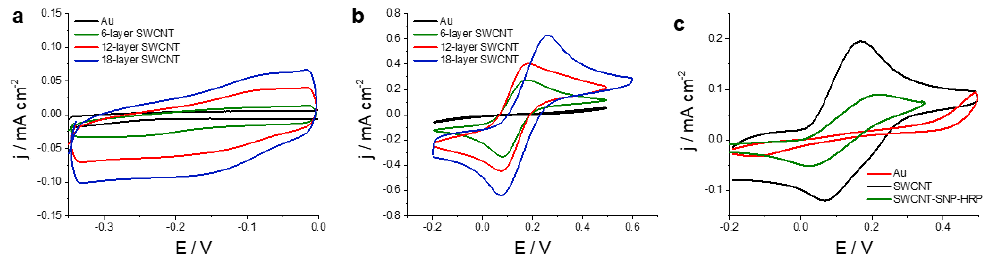
Figure 3. Electrochemical response of printed electrodes. ( a ) CVs in PBS buffer of pH 7.4 obtained for Au and 6-, 12-, and 18-layer SWCNT printed electrodes prepared with a concentration of 7.5 mg/mL. ( b ) CVs obtained for Au and 6-, 12-, and 18-layer SWCNT printed electrodes prepared with a concentration of 7.5 mg/m in a solution of 10 mM hexacyanoferrate (III/II) and 0.1 M KNO 3 . ( c ) CVs obtained for Au printed electrode, a 12-layer of 7.5 mg/mL concentration of SWCNT printed electrode and a 12-layer SWCNT-SNP-HRP printed electrode with 5 mg/mL and 5 mg/mL concentration of SWCNT and SNP-HRP in a solution of 4 mM hydroquinone in PBS of pH 7.4. All voltammograms were acquired at a scan rate of 0.05 V s −1 .